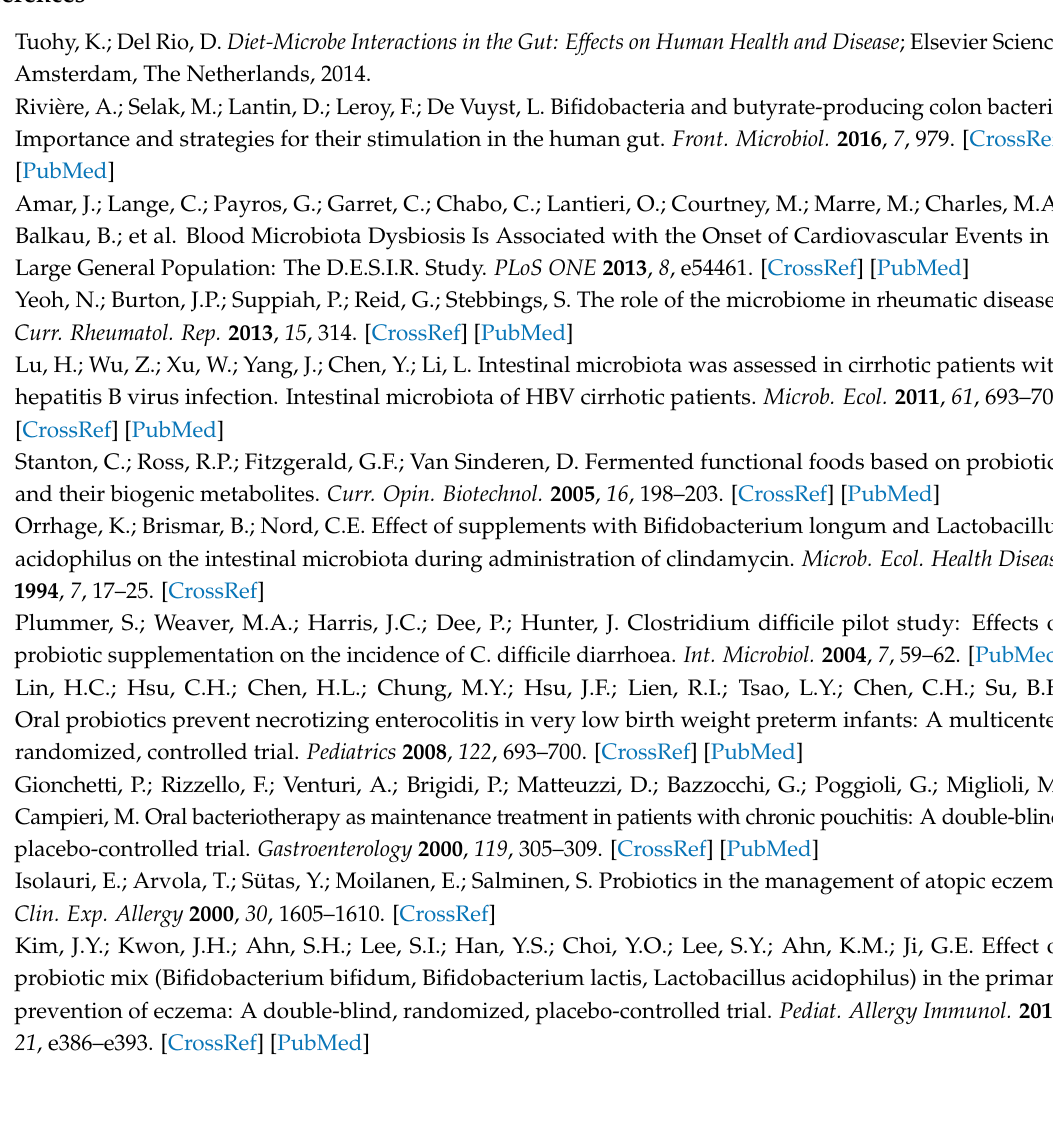
Table S1. Flow chart for the clinical study of volunteers, Table S2. Sequencing statistics and metadata, Table S3. Full taxonomic composition, Table S4. Composition of the microbial cooperatives, Table S5. Taxa for which the relative abundance changed significantly after the FDP consumption, Table S6. Metabolic pathways for which the relative abundance changed significantly after the FDP consumption, Table S7. Metabolic modules for which the relative abundance changed significantly after the FDP consumption, Table S8. Microbial taxa with significantly changed relative abundance after the course of FDP consumption for the groups of responders and